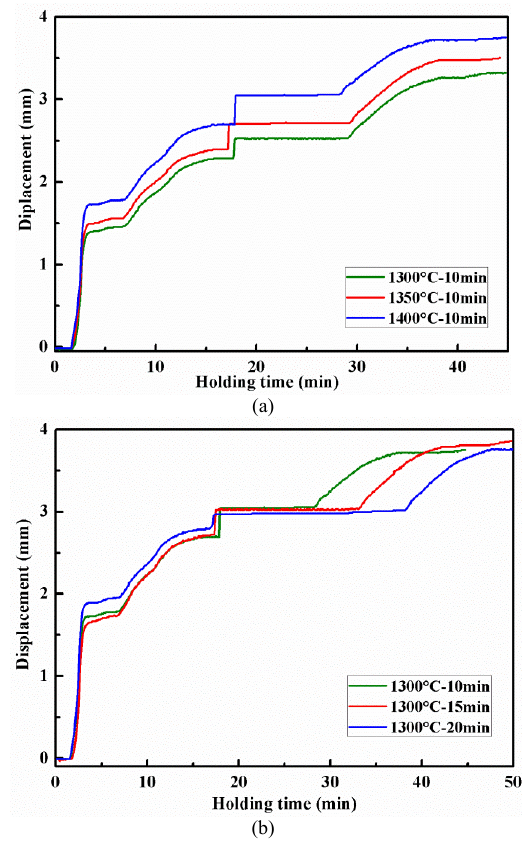
Variation of the piston displacement during sintering of mixtures versus time: (a) at 1300, 1350, and 1400 ℃ for 10 min and (b) at 1300 ℃ for 10, 15, and 20 min.